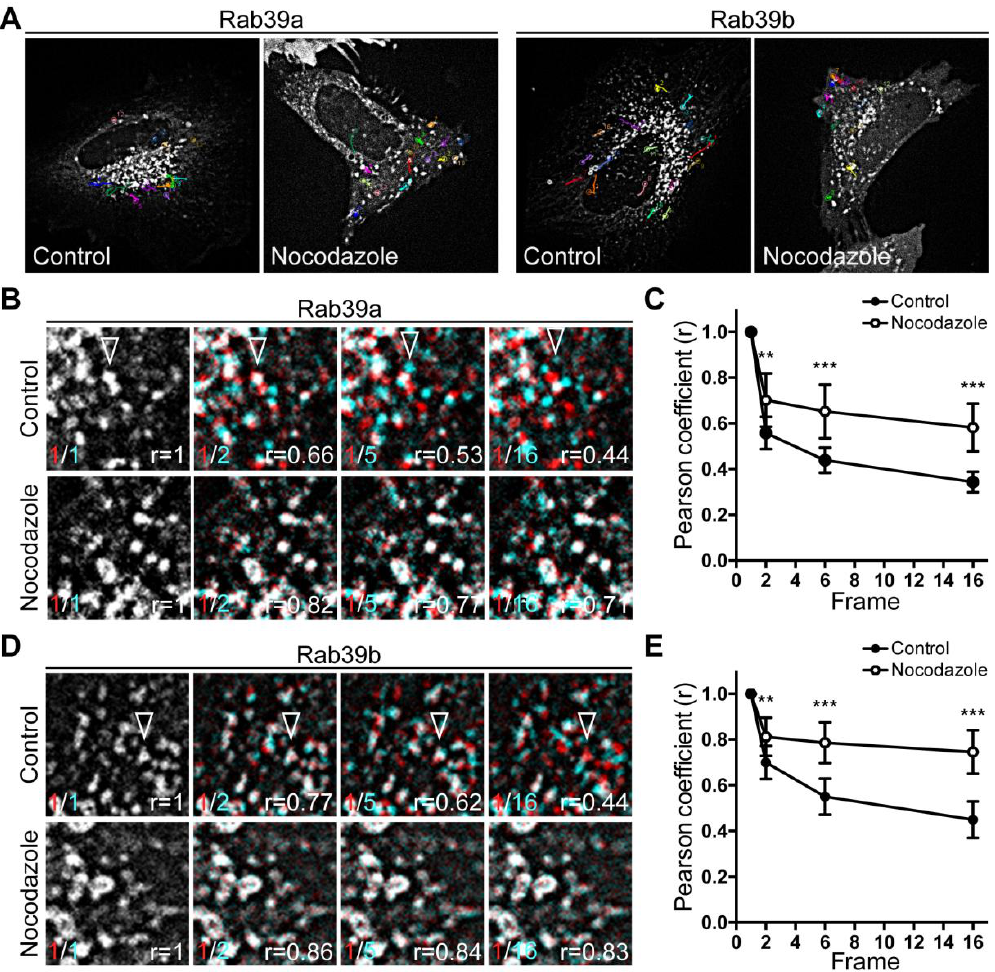
Figure 3. Movement of Rab39a- and Rab39b-vesicles along microtubules. HeLa cells overexpressing GFP-Rab39a or GFP-Rab39b were incubated with DMSO (control) or with 10 μM nocodazole for 1 h at 37 °C. Images were taken every 1 s during 16 s by spinning disk microscopy. ( A ) Trajectories of the selected vesicles in control and nocodazole-treated cells were drawn by MTrackJ FiJi plugin. Images are representative of ten independent experiments. ( B , D ) Selected frames of movies of HeLa cells overexpressing GFP-Rab39a ( B ) or GFP-Rab39b ( D ) under control conditions ( top ) and nocodazole treatment ( bottom ). Open arrowheads point out a selected vesicle. r indicates Pearson correlation coefficient between the position of the vesicles in the first frame (red) and their localization in the subsequent frames (cyan). White pixels correspond to the overlapping between the initial and the actual position of the vesicles. ( C , E ) Line graphs represent the Pearson correlation coefficients calculated for every vesicle within the whole cell in the experimental conditions shown in ( B , D ). Control cells are indicated with filled circles ( n = 12 for Rab39a and n = 10 for Rab39b) and nocodazole-treated cells are represented by empty circles ( n = 16 for Rab39a and n = 8 for Rab39b). Significance was calculated by resampling techniques (** p < 0.01 and *** p < 0.001).